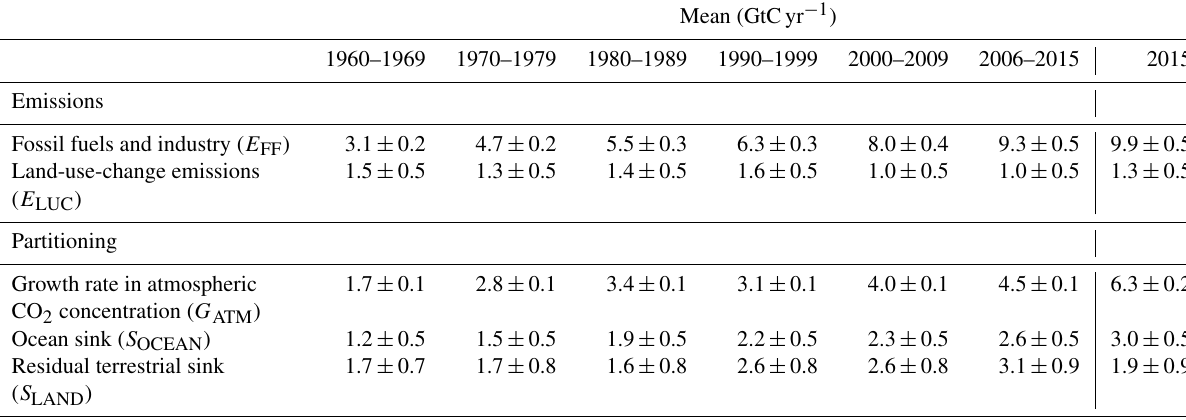
Table 8. Decadal mean in the five components of the anthropogenic CO 2 budget for the periods 1960–1969, 1970–1979, 1980–1989, 1990– 1999, and 2000–2009, as well as the last decade and last year available. All values are in GtCyr − 1 . All uncertainties are reported as ± 1 σ . A data set containing data for each year during 1959–2014 is available at http://cdiac.ornl.gov/GCP/carbonbudget/2015/. Please follow the terms of use and cite the original data sources as specified in the data